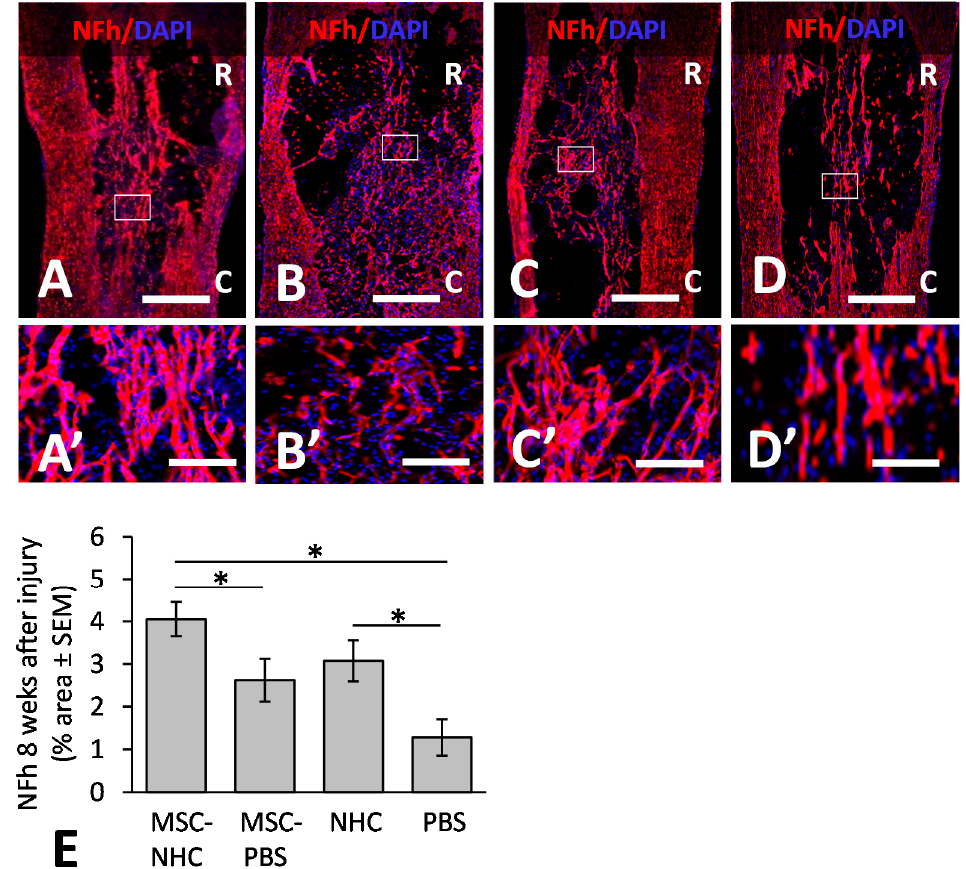
Figure 4. Axon presence in the injury site. Photomicrographs showing axons stained for NFh (red) in the injury site with MSC-NHC ( A ), MSC-PBS ( B ), NHC ( C ), or PBS ( D ) at 8 weeks after injury. Sections were counterstained with the nucleus marker, DAPI (blue). Images in panels ( A’ – D’ ) are enlargements of the outlined area in panels ( A – D ), respectively. The scale bar in ( A – D ) is 450 µm. Scale bar in ( A’ , C’ ) is 125 µm, and 115 µm in ( B’ , D’ ). In ( A – D ), the rostral (R) and caudal (C) orientation of the horizontal sections are indicated. ( E ) Bar graph of the percentage area of injury site positive for NFh at 8 weeks after injury. There were significantly more NFh+ axons in the injury site with MSC-NHC compared with MSC-PBS and PBS only. Asterisks indicates p < 0.05. Bars in the graph represent SEM. Abbreviations: DAPI = 4 ′ ,6-diamidino-2-phenylindole; MSC = mesenchymal stromal cells; NFh = neurofilament high molecular weight; NHC = nanofiber-hydrogel composite; PBS = phosphate-buffered saline; SEM = standard error of the mean.